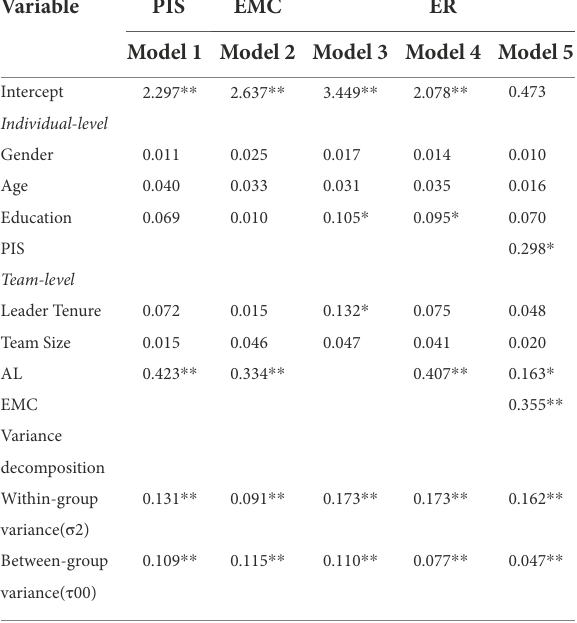
TABLE 3 The results of main effect and mediating effect.